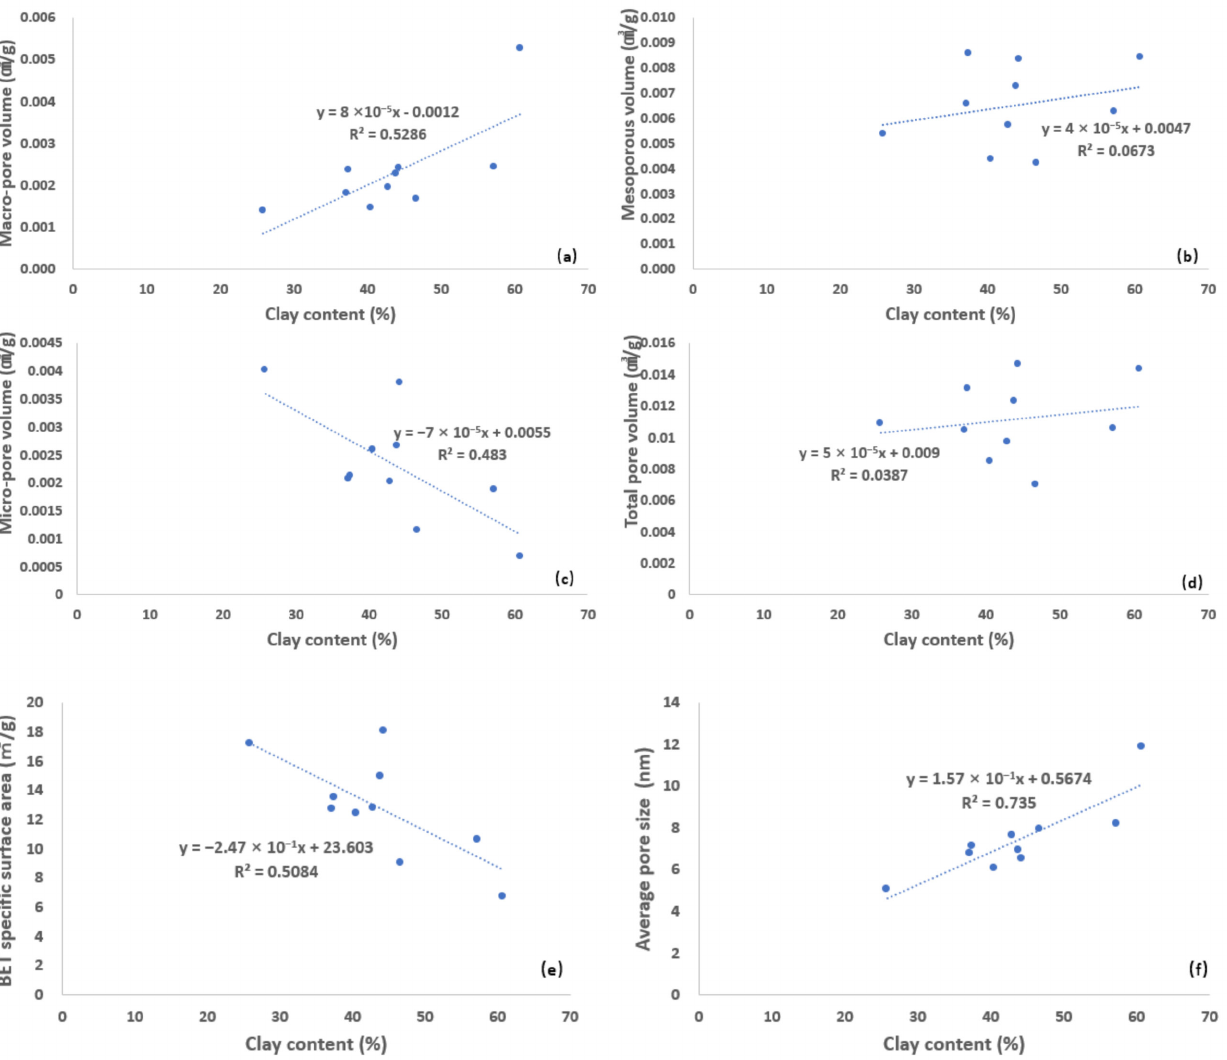
Figure 10. Relationship between microscopic pores and clay content of lower Cambrian Niutitang formation black shale in Wenshuicun section, Guizhou province; ( a ) the cross plot of macropore volume and clay content; ( b ) the cross plot of mesopore volume and clay content; ( c ) the cross plot of micropore volume and clay content; ( d ) the cross plot of total pore volume and clay content; ( e ) the cross plot of BET specific surface area and clay content; ( f ) the cross plot of average pore size and clay